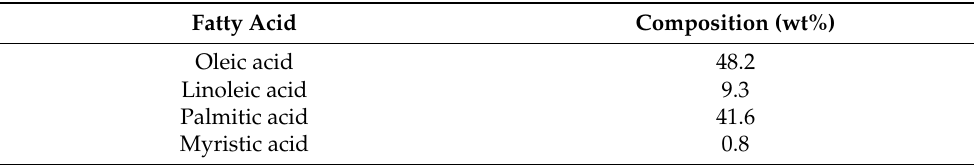
Table 1. Fatty acids composition of the waste cooking